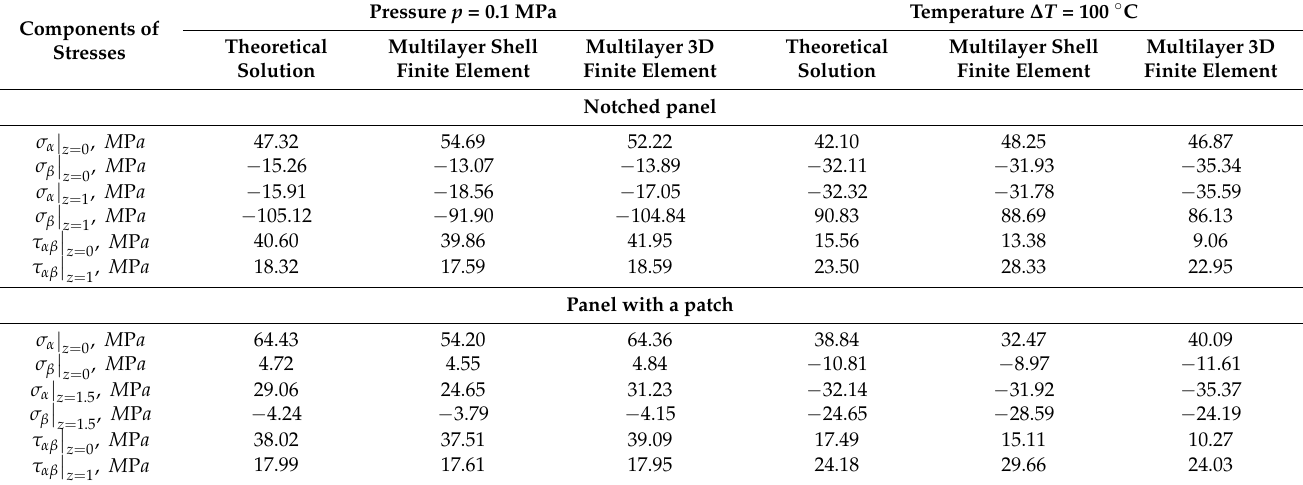
Table 6. Comparative analysis of